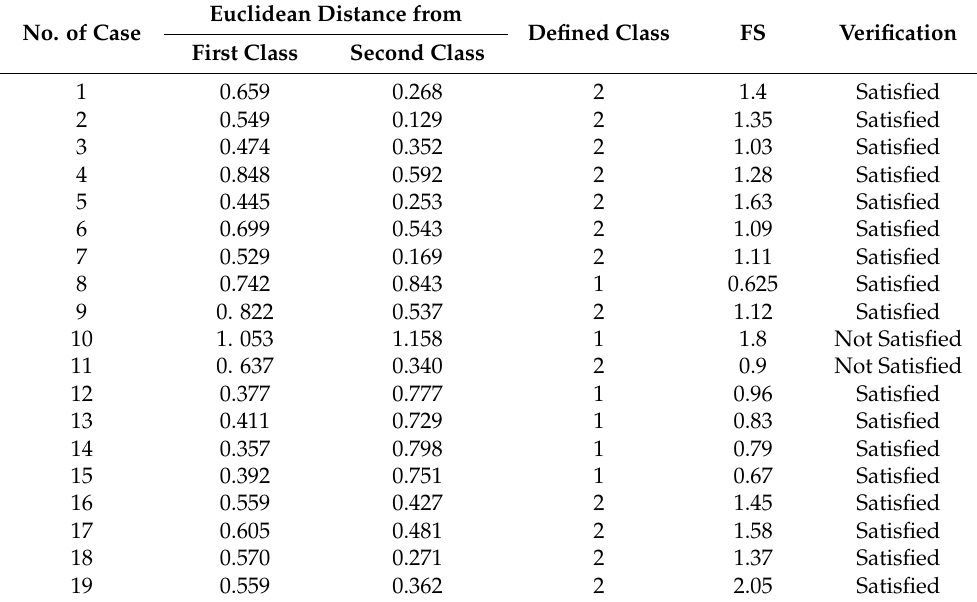
Table 3. Optimization and clustering of the considered dataset by the HS algorithm.